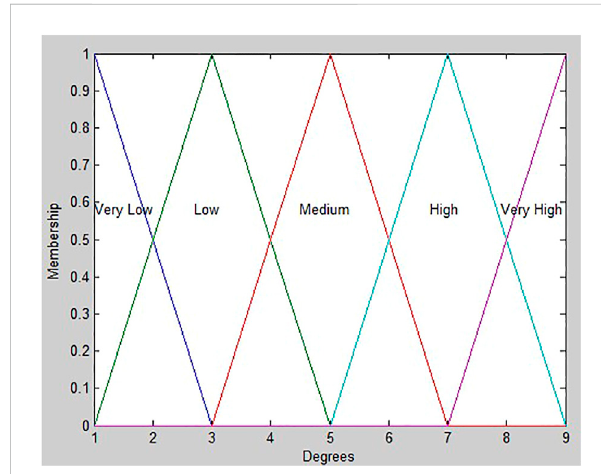
FIGURE 4 The membership functions of the inputs “ availability of maintenancepersonnel ” , “ operator reliability ” and “ refusalofextended hours or overtimes ” .